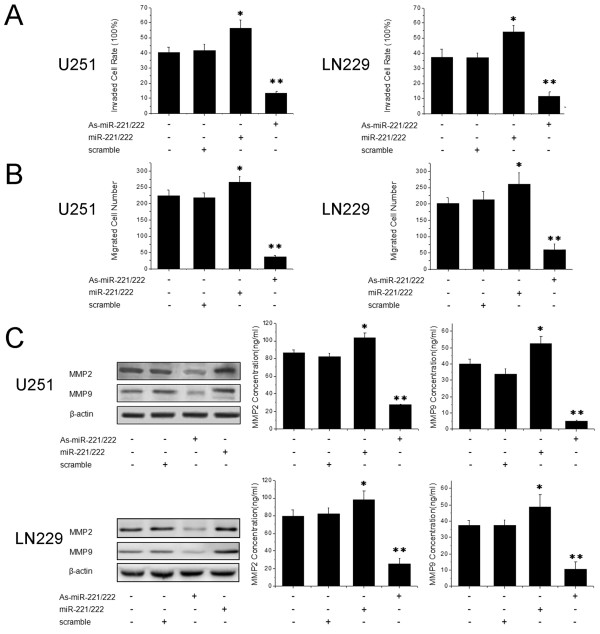
MiR-221 and miR-222 play an important role in glioma cell invasion. (A) and (B) Cells were transfected with As-miR-221/222 or miR-221/222, and transwell assays and wound healing assays were performed. (C) Cells were transfected with As-miR-221/222 or miR-221/222 and MMP2 and MMP9 protein levels were detected by western blot assays. β-actin protein was assayed as a control. MMP2 and MMP9 levels were also measured by ELISA assays. Error bars represent standard deviation and were obtained from three independent experiments. * P <0.05 compared with control group, ** P <0.01 compared with control group.